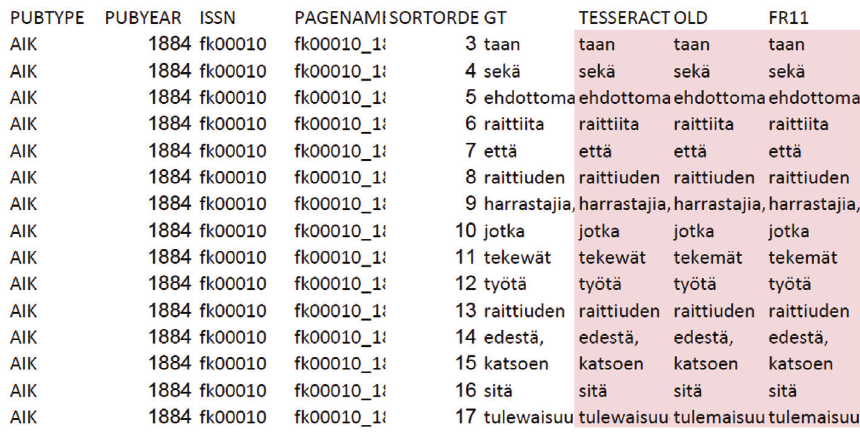
Fig. 3: Example of parallel GT